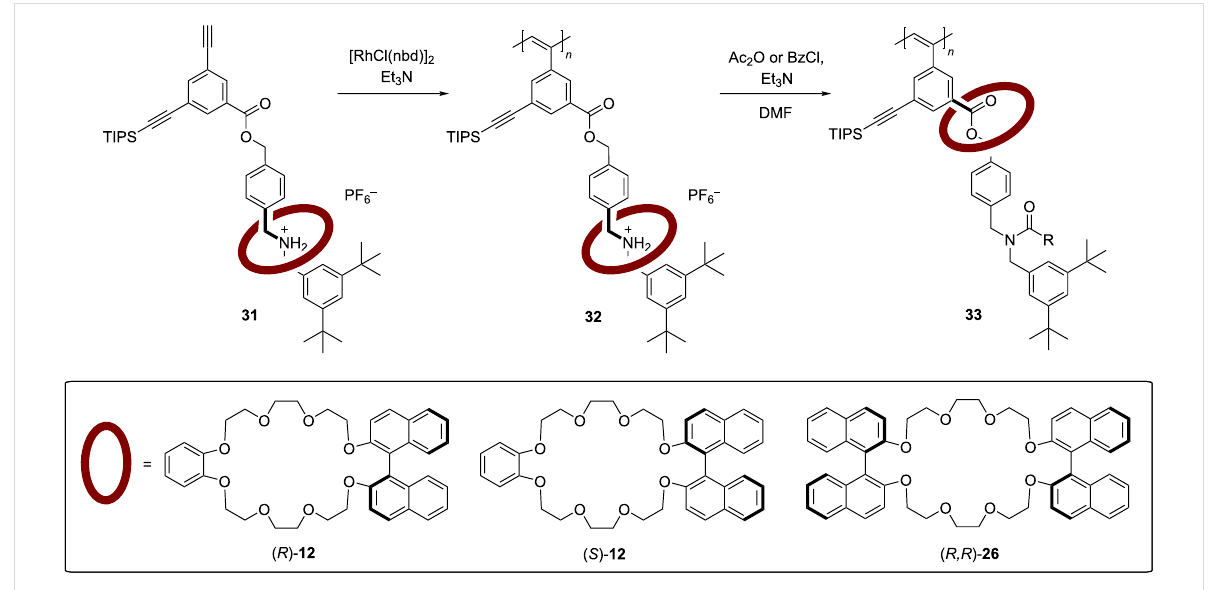
Figure 7: Takata´s chiral polyacetylenes 32 / 33 featuring BINOL-based [2]rotaxane side